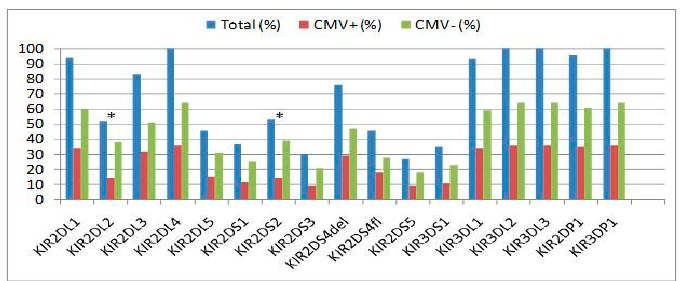
Figure 1. Frequency of CMV infection (CMV+) relative to each killer cell immunoglobulin-like receptor gene. The asterisk (*) indicates statistical significance.